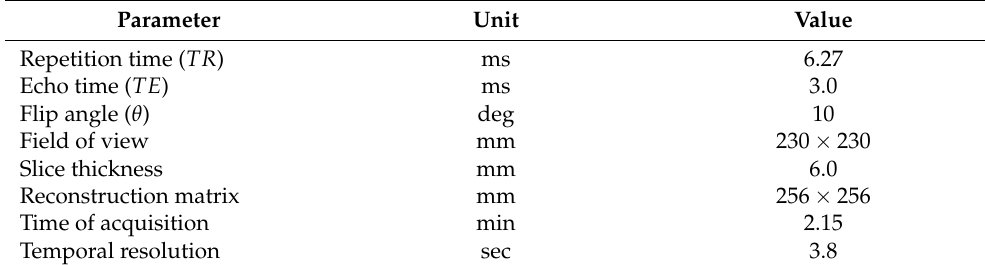
Table 1. T1-perfusion MR image acquisition protocol.